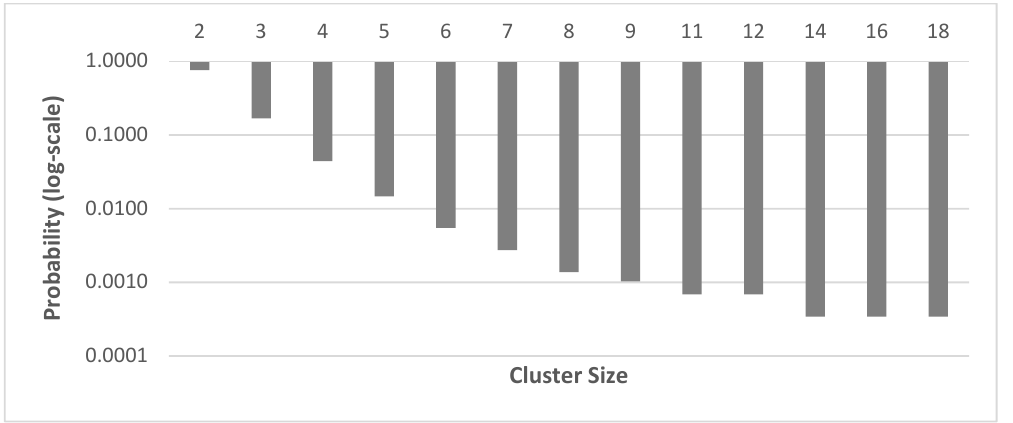
Figure 1. Distribution of cluster sizes (2013–2019).